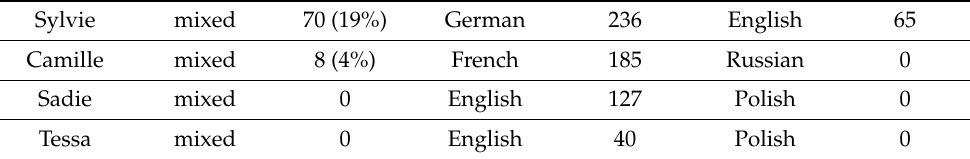
Table 3. The total numbers of ANPs in child naturalistic speech.